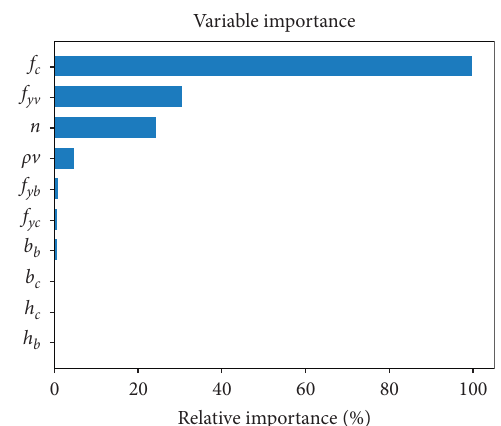
Figure 9: Relative feature importance of all input